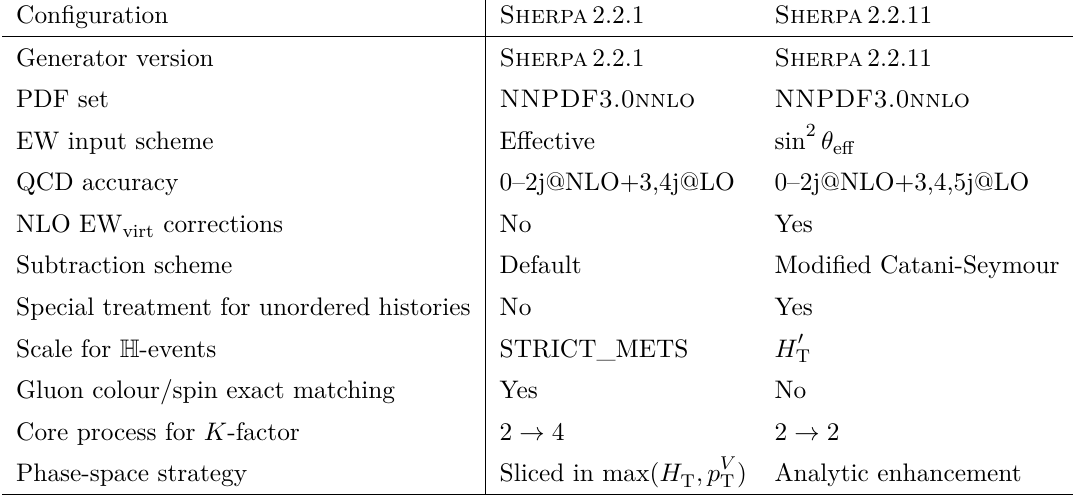
Table 1 . Summary of the Sherpa 2 . 2 . 1 and 2.2.11